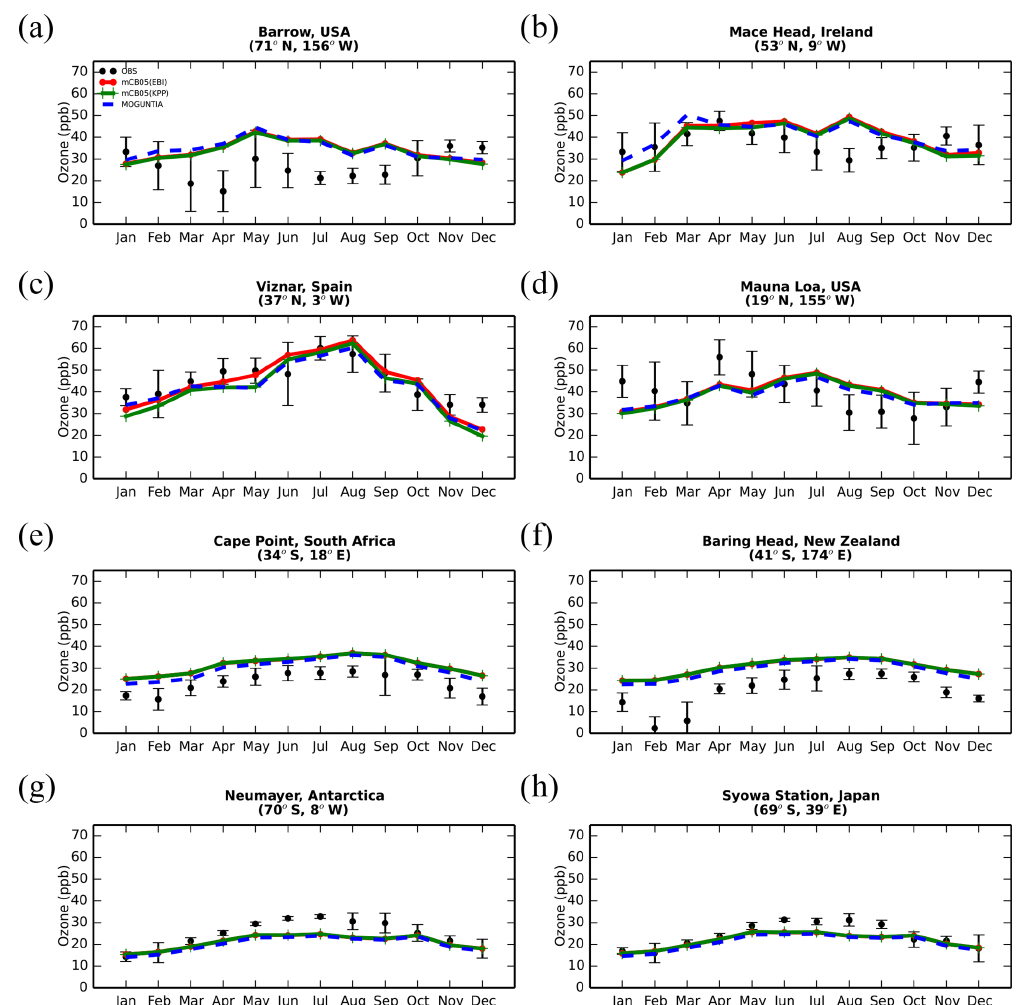
Figure 5. Monthly mean comparison of TM5-MP surface O 3 (ppb) against surface observations (black line) from EMEP and WOUDC databases for the two chemistry schemes, mCB05(KPP) (green line) and MOGUNTIA (blue line), using colocated model output for 2006 sampled at the measurement times; error bars indicate the standard deviation in the monthly means. For comparison, model results of mCB05 with the EBI solver (red line) are also